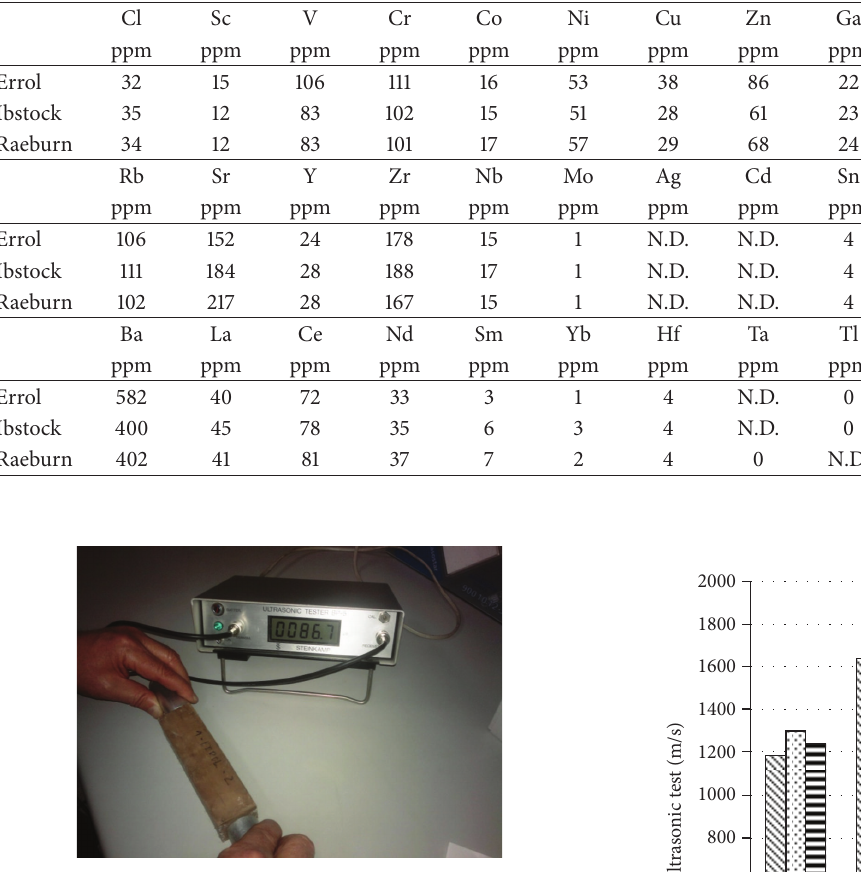
Figure 5: Ultrasonic tests.